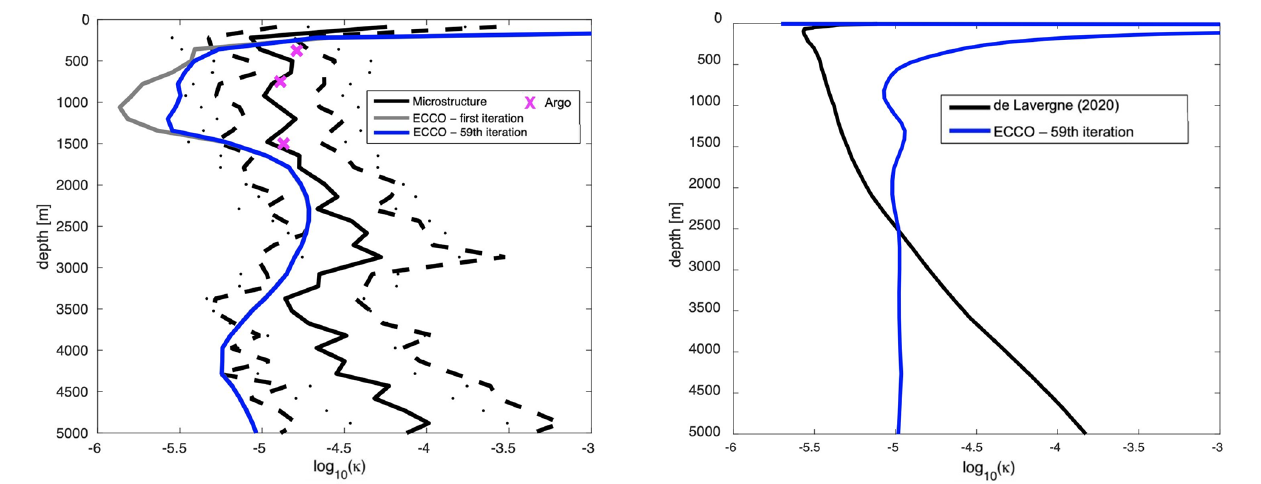
Figure 4. (a) κ ρ profiles averaged over all microstructure observation locations (shown in Fig. 2) from the first iteration of the optimization ( E -CTRL 0 – grey curve) and from the (final) 59th iteration of the optimization ( E -CTRL – blue curve). Also shown is the average of κ ρ profiles from the full-depth microstructure observations (black curve) presented in Waterhouse et al. (2014) (see their Fig. 6; also see Fig. 5 of the present study) with 1 spatial standard deviation flanking the average (dashed black curves) and an approximate factor of 3 uncertainty flanking the average (dotted black curves), as well as the average of κ ρ (magenta X marks) at each of the depth bins in the Whalen et al. (2015) product. At each location, the simulated profiles are extracted and the base-10 logarithms of the geometric averages of the observed and ECCO-estimated κ ρ (units in m 2 s − 1 ) are shown. (b) κ ρ profiles averaged over the entire ocean from the 59th iteration of the optimization ( E -CTRL – blue curve) and from the de Lavergne et al. (2020) tidal mixing product (black curve).